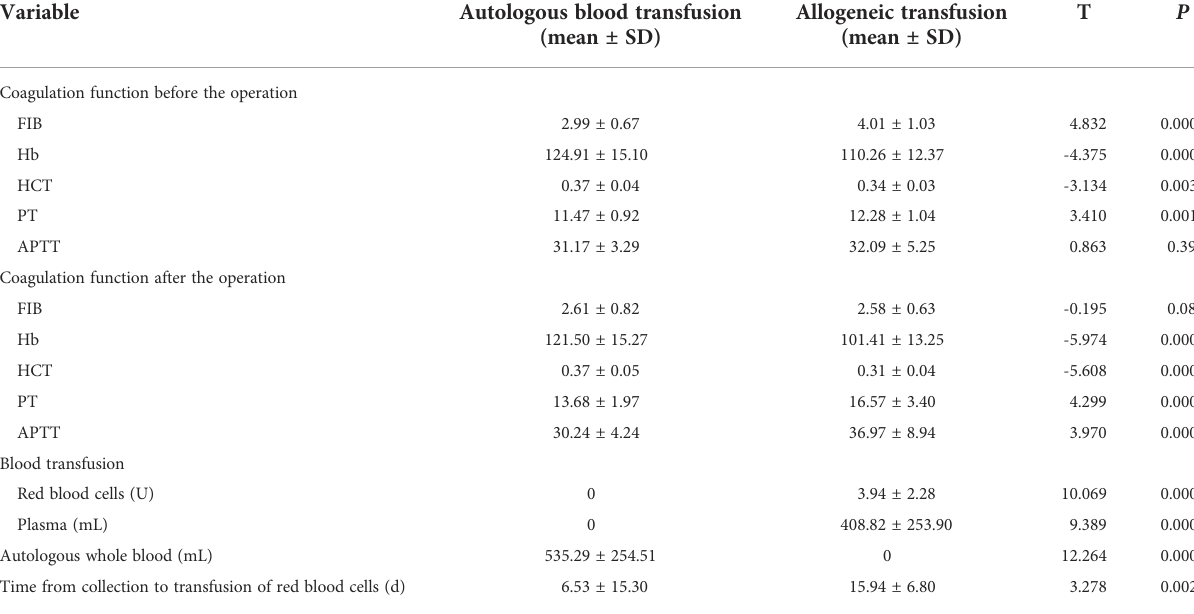
TABLE 4 Coagulation function and blood transfusion of patients in the two groups before and after the operation.